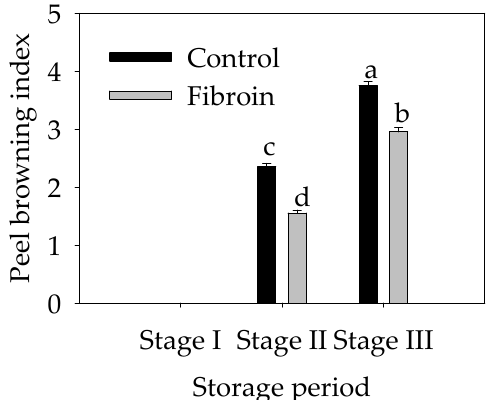
Figure 1. Effect of fibroin treatment on the peel browning index of harvested banana fruit during cold storage. Data are presented as means ± standard errors ( n = 3). The means with different letters are significantly different ( p < 0.05).